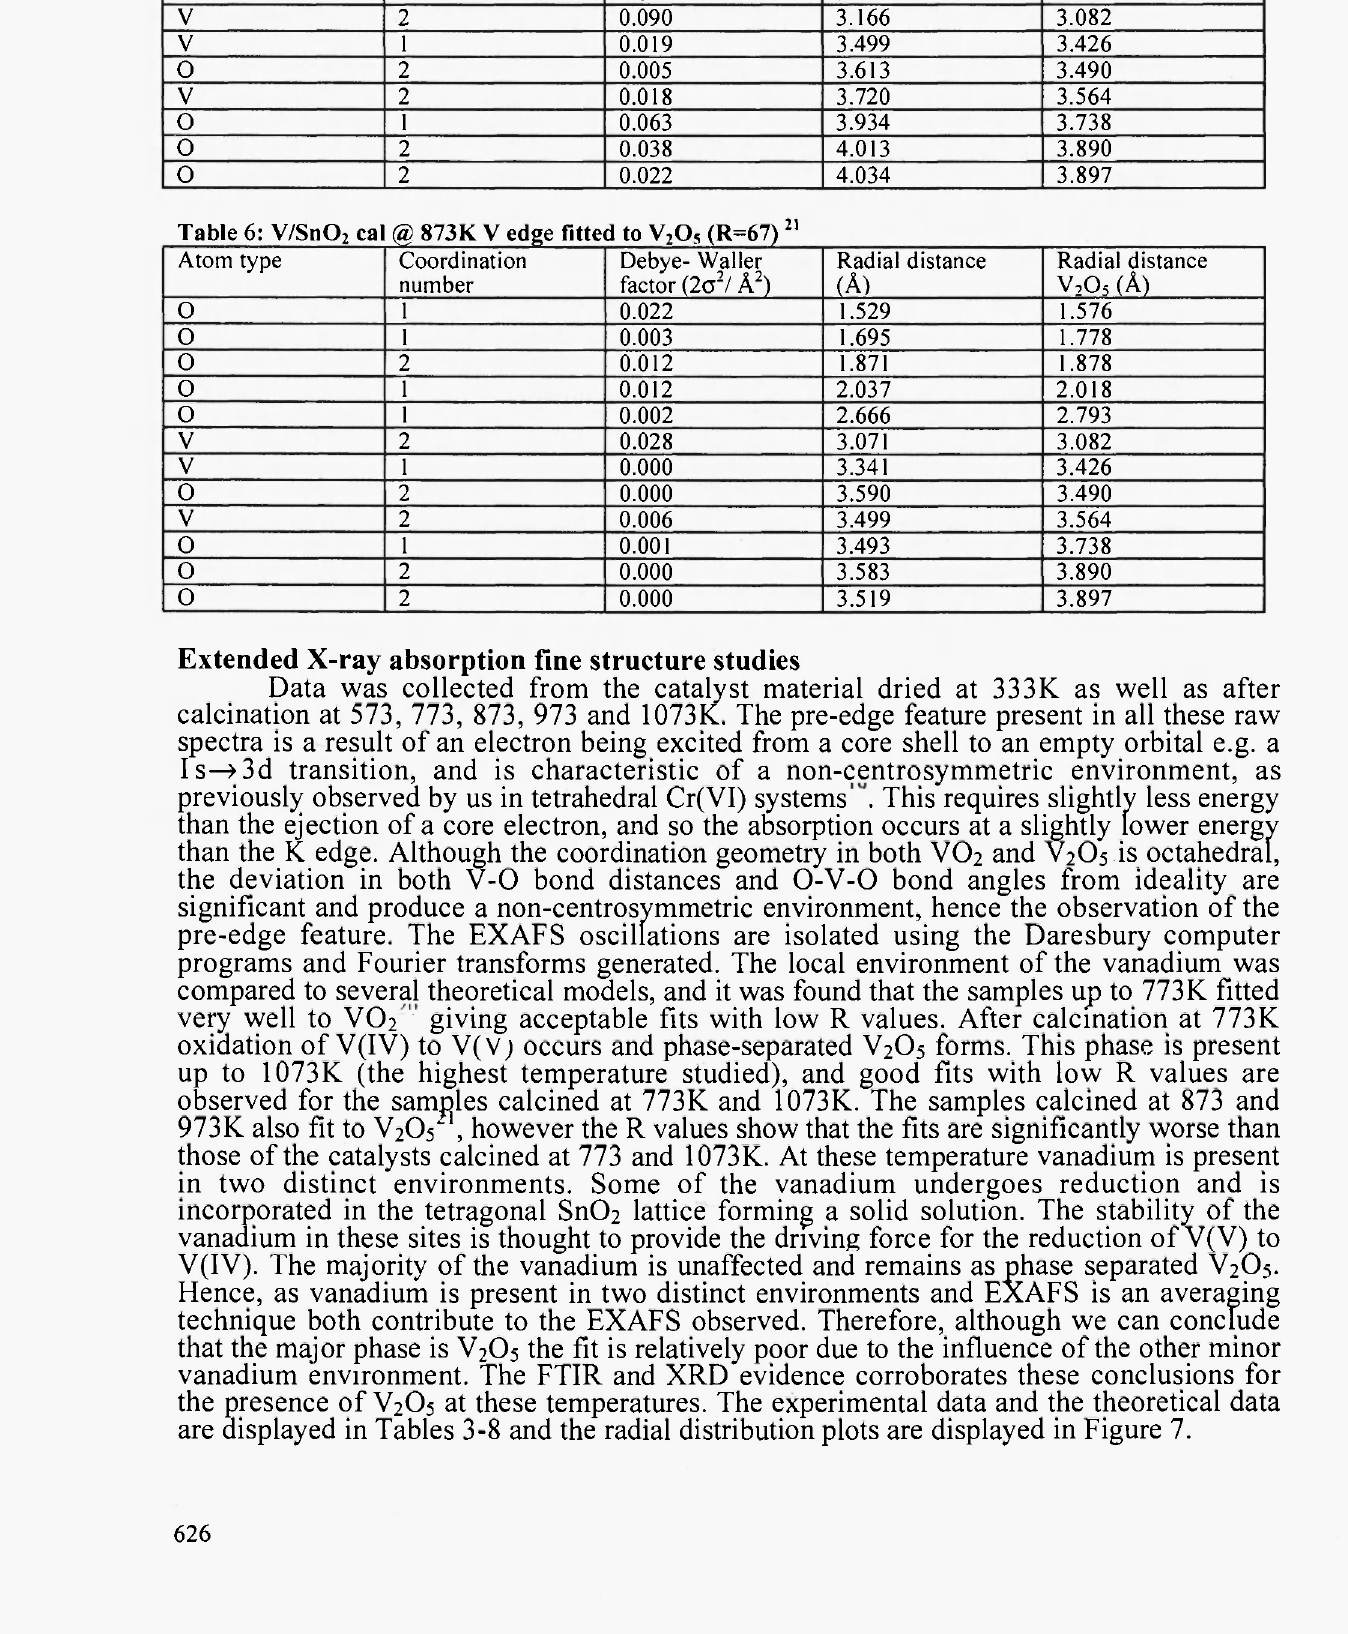
Table 6: V/SnQ 2 cal @ 873K V edge fitted to ν 2 Ρ 5 (R=67) 21 Atom